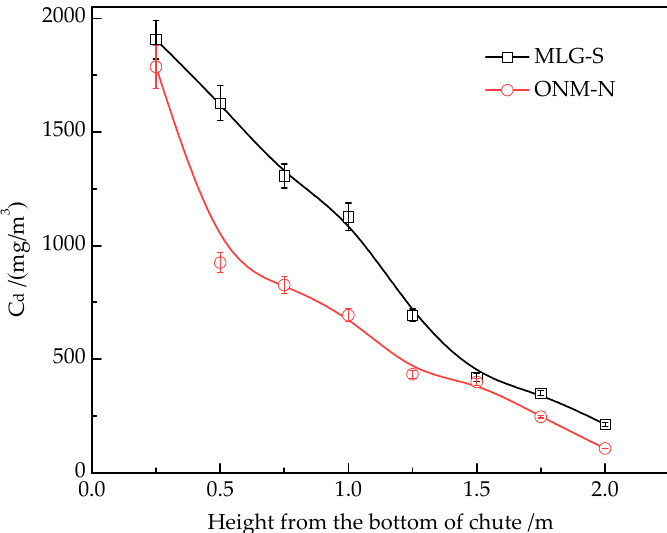
Figure 9. Concentration distribution of dust along the height of chute.